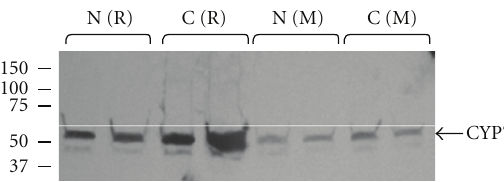
Figure 1: Comparison of the e ff ects of dietary cholesterol on hepatic cholesterol 7 α hydroxylase protein levels in rats and Mice. Rats (R) and mice (M) were fed normal (N) chow diets with or without 1% or 2% cholesterol (C) for 5 days. A representative West- ern blot of hepatic microsomal cholesterol 7 α hydroxylase protein is presented.